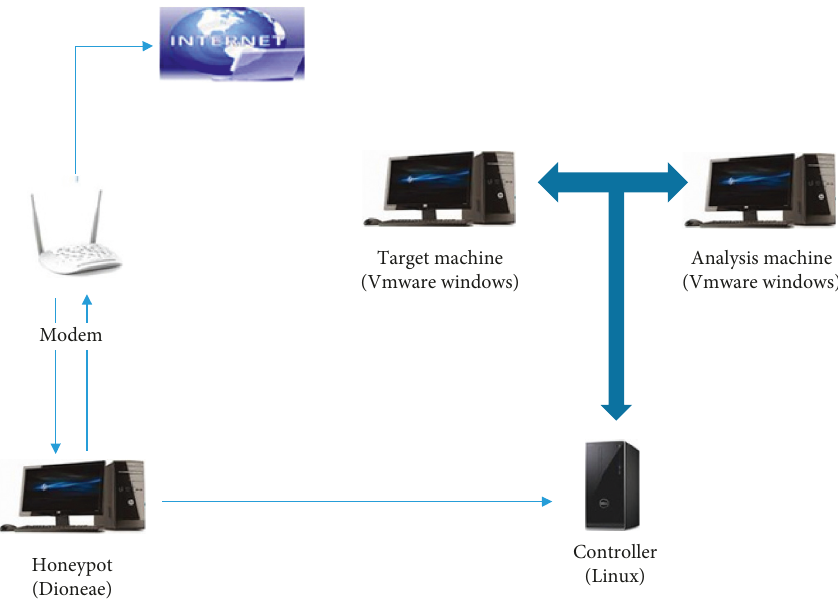
Figure 1: Laboratory components.